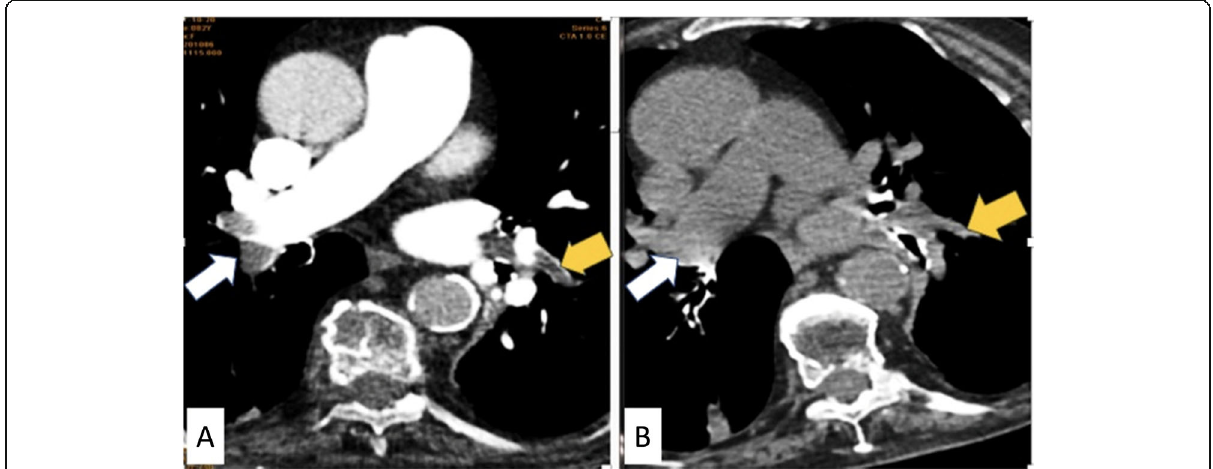
Fig. 2 a Axial CTPA image. b Axial non-contrast image shows a case of acute pulmonary embolism with hyperdense thrombus seen at right distal main pulmonary artery (white arrows).and left lower sub-segmental peripheral branch (yellow arrows) with corresponding filling defect at CTPA